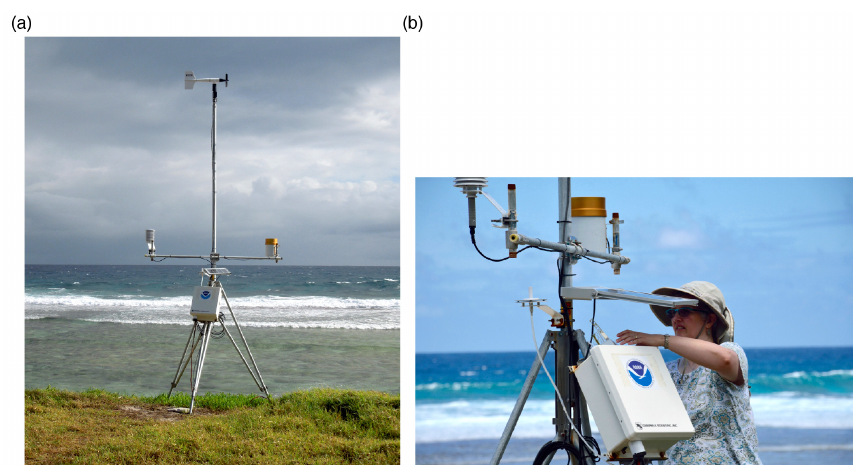
Figure 2. (a) The surface met station in its final position above the beach at Kiritimati. The anemometer sits atop the assembly, while the temperature–humidity sensor (on the left) and rain gauge (on the right) are attached to the crossbeam. Just below the crossbeam is the solar panel, and the box containing the Campbell datalogger, the power supply, and the barometer is mounted just below that. A plastic tube runs from the barometer out the tube on the bottom of the box, and can be seen mounted within a white disk just to the left of the solar panel. (b) The 26 March 2017, 00:00UTC radiosonde being put on the Campbell box in the shade of the solar panel prior to launch. The pressure tube egress and mount are clearly visible. Photo courtesy of Gabriele Kerber.